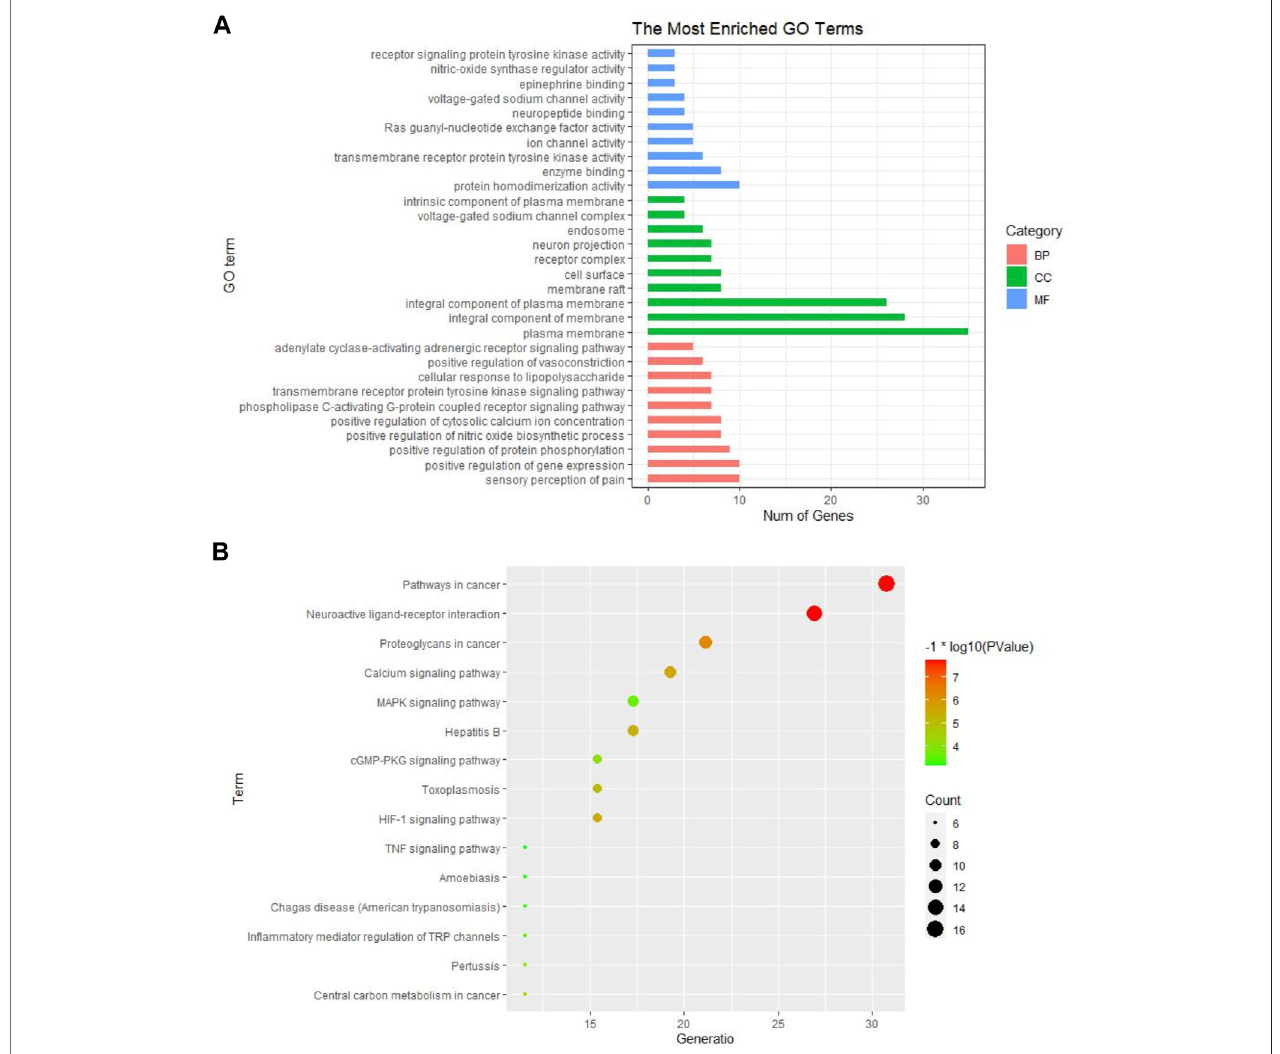
FIGURE 4 | GO and KEGG pathway enrichment analysis of GEB in treatment for NPP. (A) GO analysis of signi fi cant items of 52 common targets in different functional groups (BPs, CCs, MFs) (B) The top 15 KEGG pathways based on their p -values. The larger the circle, the greater the number of the target genes in the term. Also, color highlights the size of the FDR: the redder the color, the more signi fi cant the value.